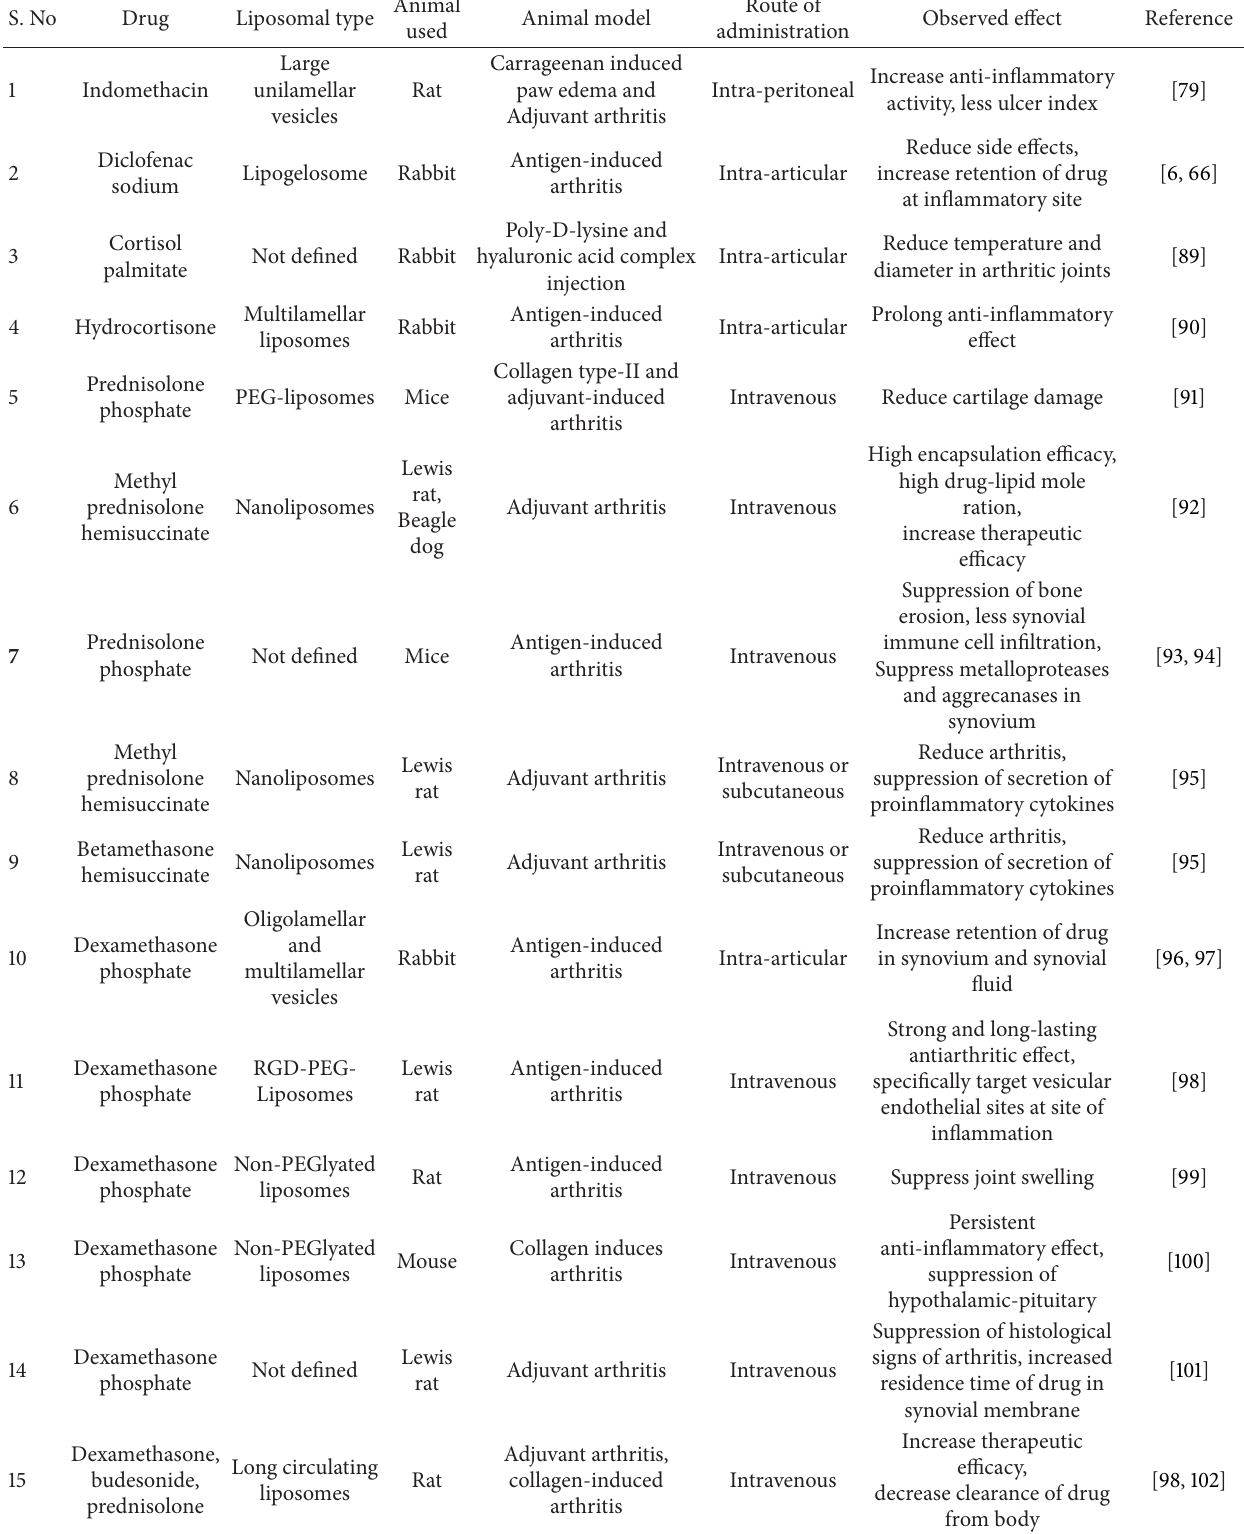
Table 3: Liposomal drug formulations in treatment of Rheumatoid